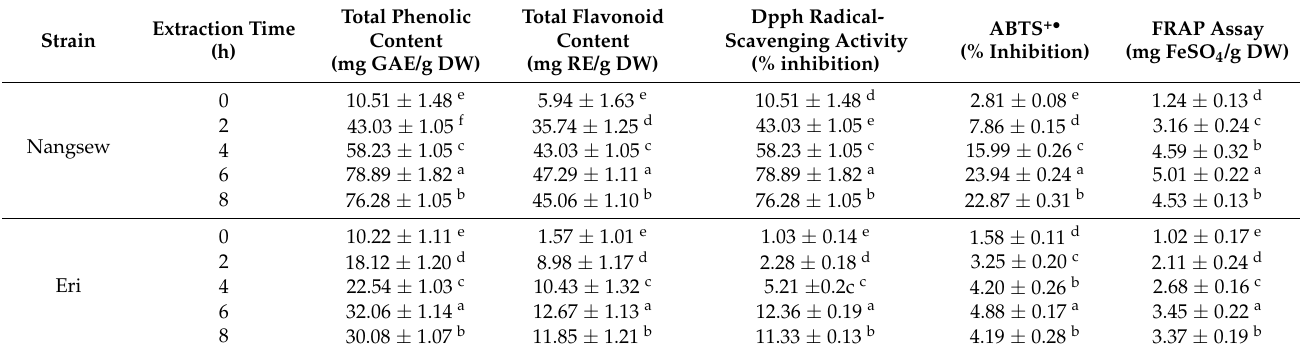
Values are expressed as mean ± standard deviation ( n = 3). Means with different letters in the column within the same strains were significantly different at the level p <